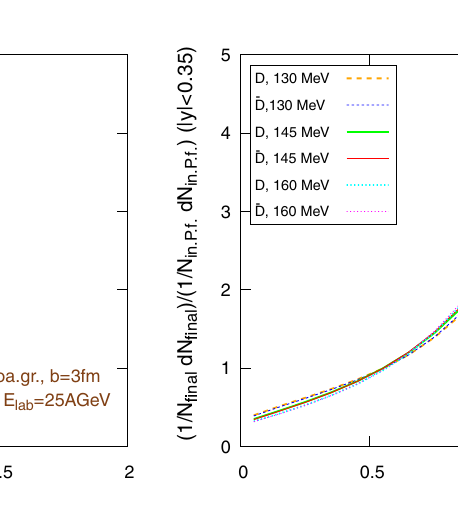
| y | < 0 . 35, for Au+Au collisions at E UrQMD/hybrid model. The hadronization parameters are (cid:23) p = 0 . 05 (cid:13) (cid:14) = 0 . 6fm. Left: b = 3fm, right: b = 7fm r D and rms